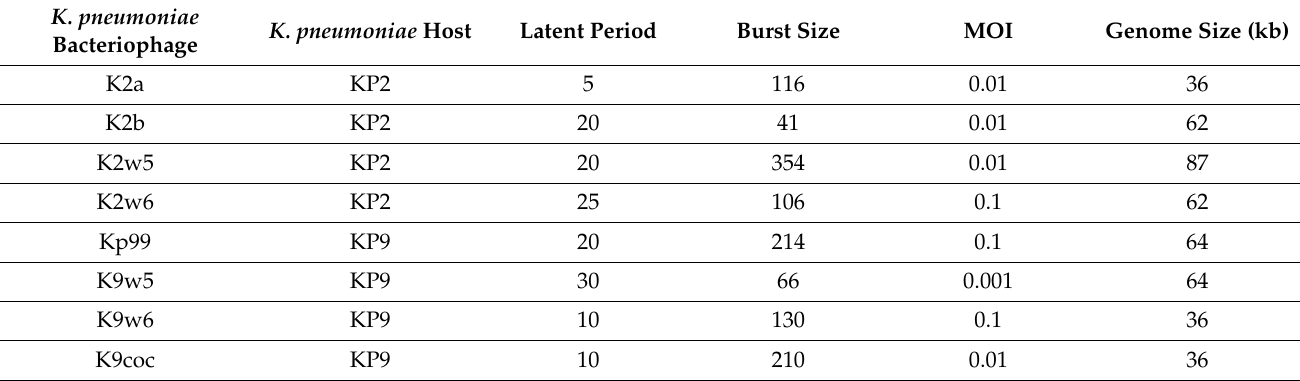
Table 3. The latent periods and burst sizes for different